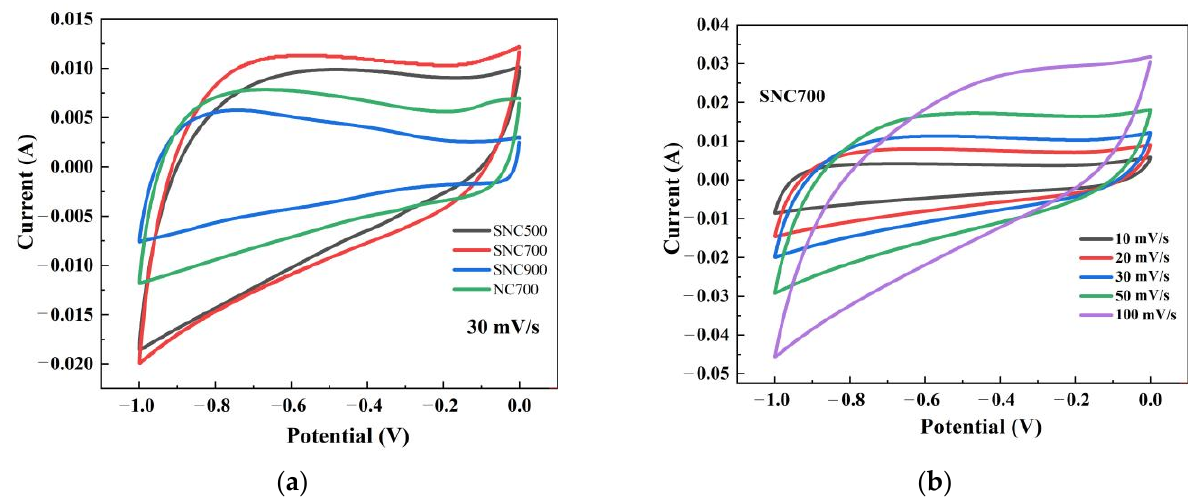
Figure 9. NC and SNC cyclic voltammetry curves at 30 mV/s scanning rate ( a ); cyclic voltammetry curves of SNC700 at different scanning rates ( b ).